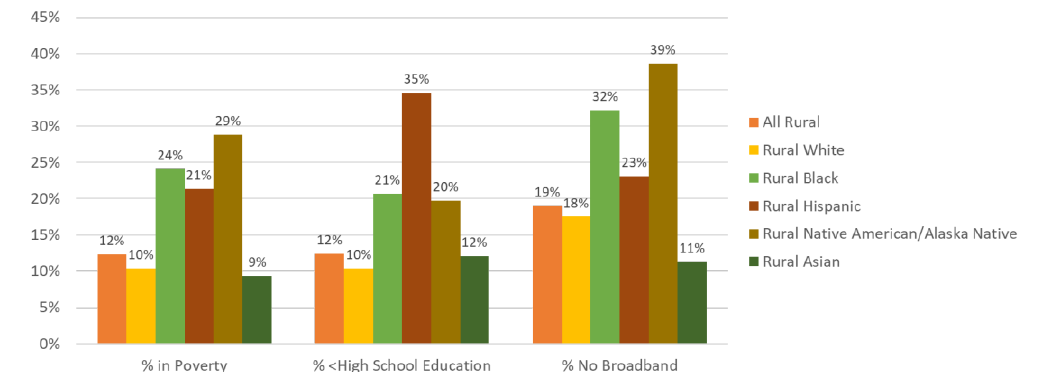
Figure 3. Social determinants of health across rural racial/ethnic groups (findings reported by Probst et al. based on American Community Survey data) [77 – 80].